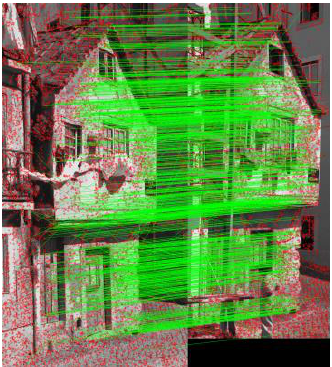
Figure 9. Case study No.1: Feature matching and geometric validation (phase 3 in Figure 7).